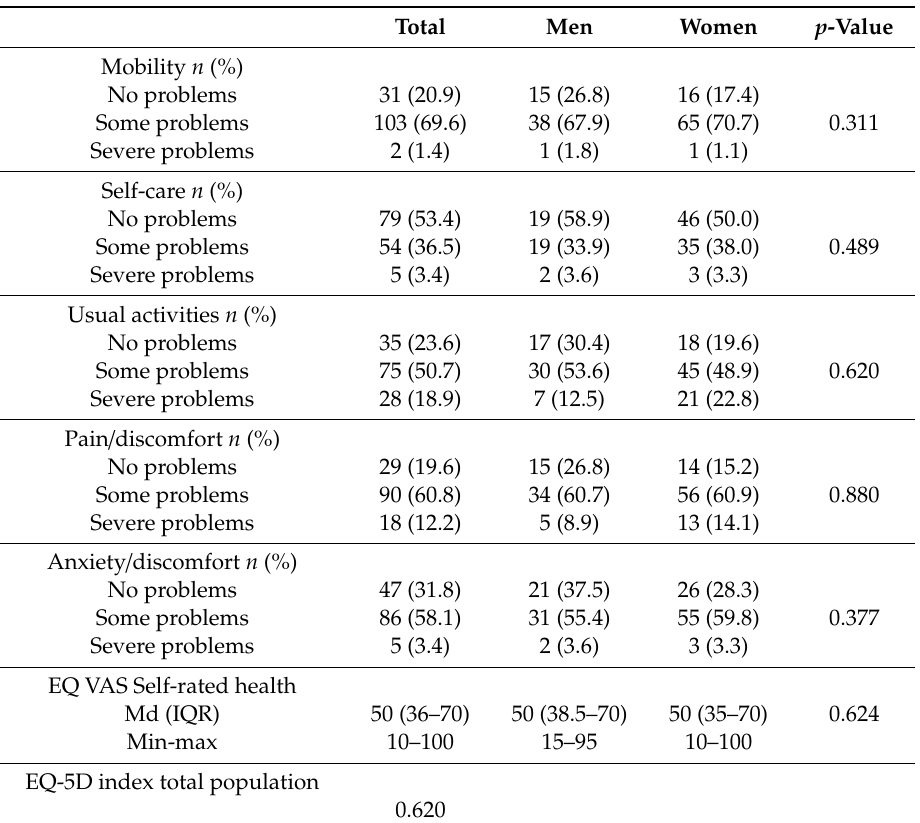
Table 2. Responses to EQ-5D. The descriptive system comprises 5 dimensions of standardized measures. Each dimension has 3 levels; no problems, some problems & severe problems. Results are described as absolute and relative frequencies ( n / %) together with a statistical p -value between sexes. Analysis between sexes within EQ-5D, Pearson’s chi-squared test and between sexes within EQ VAS, T-test,